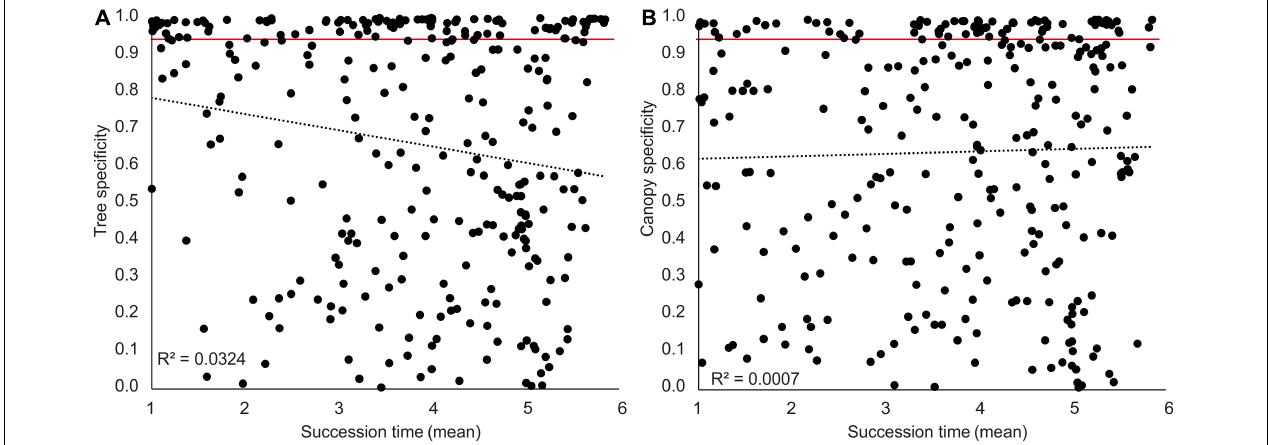
FIGURE 6 | Specificity of fungal taxa to FWD type and microclimatic conditions during succession on beech ( Fagus sylvatica ) and fir ( Abies alba ) fine woody debris (FWD) in a natural temperate forest. All taxa with abundances above 0.5% in at least 3 samples and above 1% in a single sample are represented by a dot. Species were considered specific if a minimum of 95% of the detected sequences were found in one FWD type or under one of the defined microclimatic conditions (marked with full red line). Correlations between succession time (in years) and (A) the level of specificity to a FWD type (Spearman R = -0.1304, P = 0.0246) or (B) microclimatic conditions—canopy manipulation (Spearman R = 0. 0359, P =